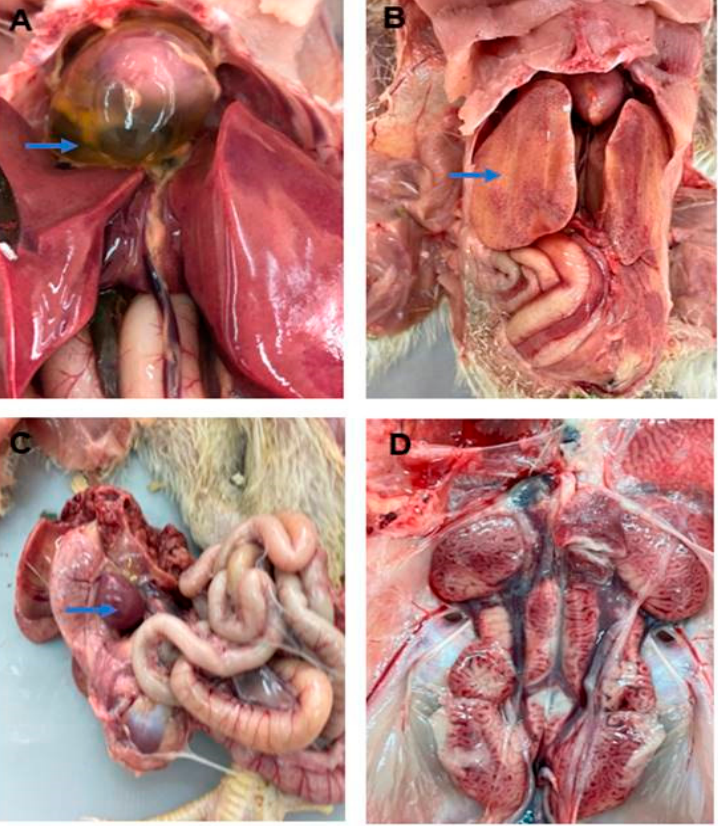
Figure 3. ( A ) The heart—accumulation of clear, straw-colored fluid in the pericardial sac (blue arrows). ( B ) The liver—pale, necrotic enlarged and friable (blue arrow). ( C ) Spleen—enlargement, congested and mottled spleen. ( D ) Kidneys—enlargement, congested, pale prominent tubules.